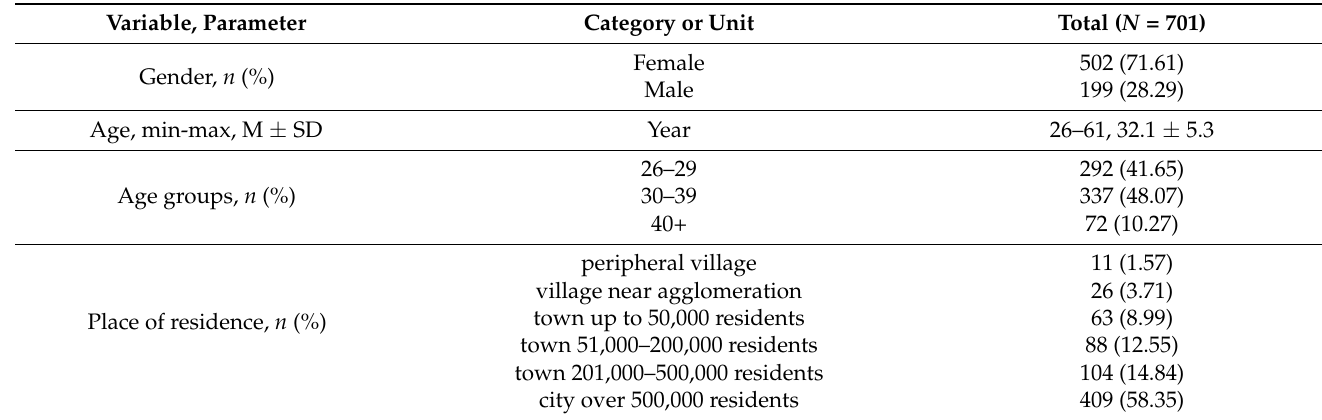
Table 1. Demographic characteristics of the study group.